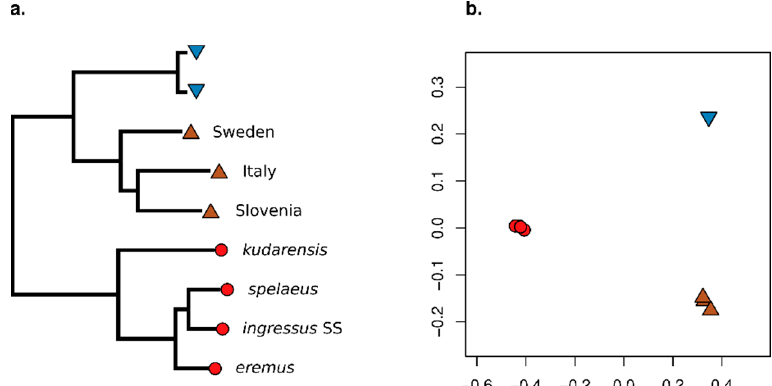
Figure 7. Evolutionary relationships among bears estimated using Consensify. For these analyses, the ingressus cave bear dataset generated using the double-stranded library protocol ( ingressus DS) has been excluded to achieve consistency of methods across all cave bears. ( a ) Maximum-likelihood tree assuming a phylogenetic model of evolution and a GTR+GAMMA model of nucleotide substitution, rooted using an Asiatic black bear as outgroup (not shown). Coloured symbols and tip labels are consistent with Figure 1. ( b ) Ordination of the same individuals along the first (x axis) and second (y axis) coordinates of a principal coordinates analysis.